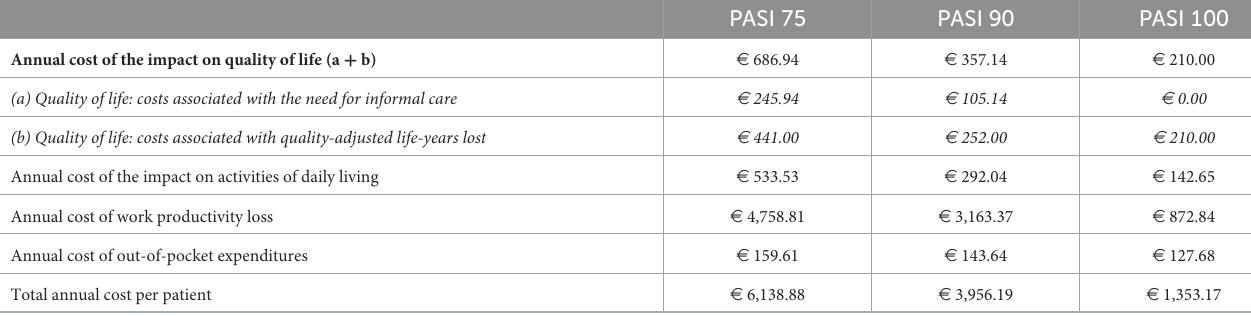
TABLE 4 Economic impact by area of analysis and PASI response in the reference